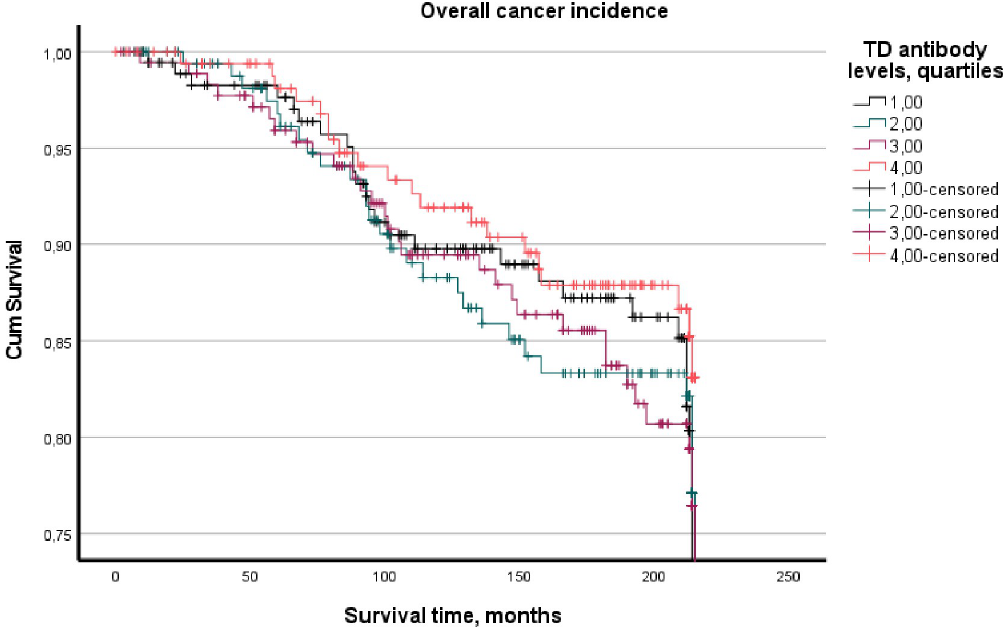
Fig 6. Overall cumulative cancer incidence stratified on quartiles of Treponema denticola antibody levels.